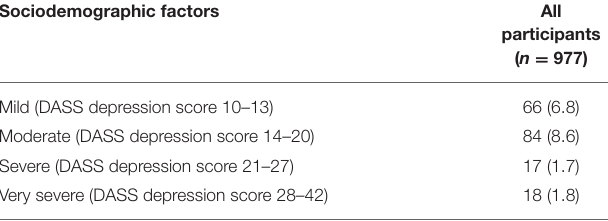
TABLE 1 | Participant characteristics (Kosovo Non-Communicable Disease Cohort, Kosovo,